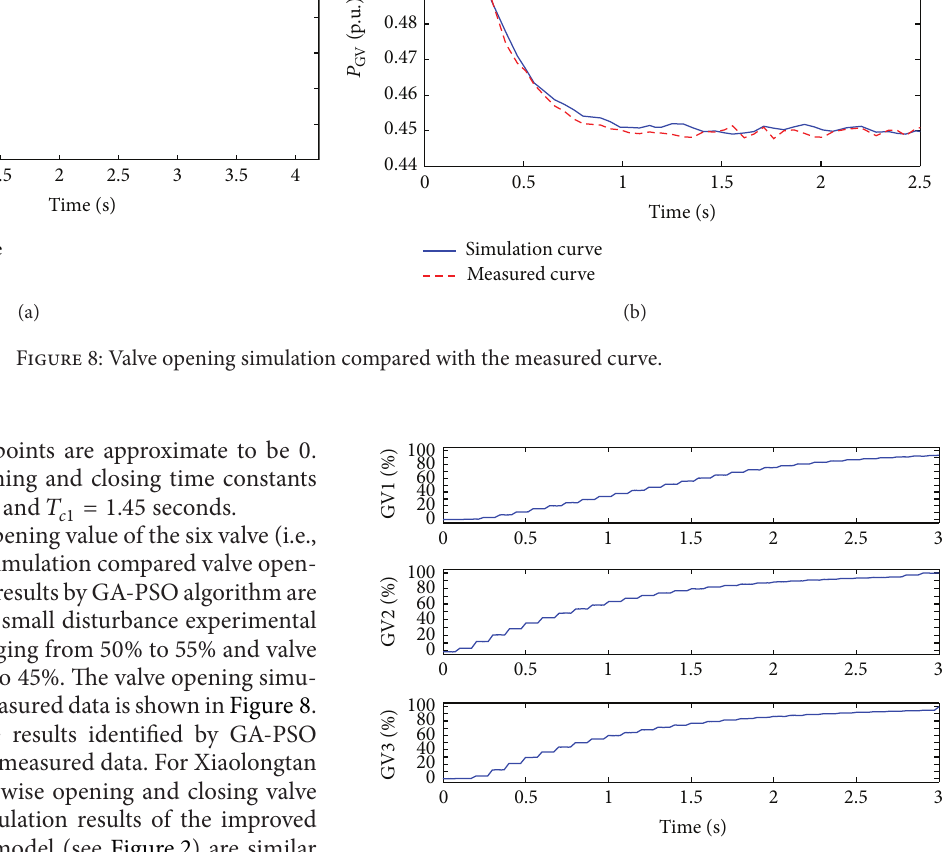
Figure 9: Servo and actuator full open recorded diagram of Qujing power plant.